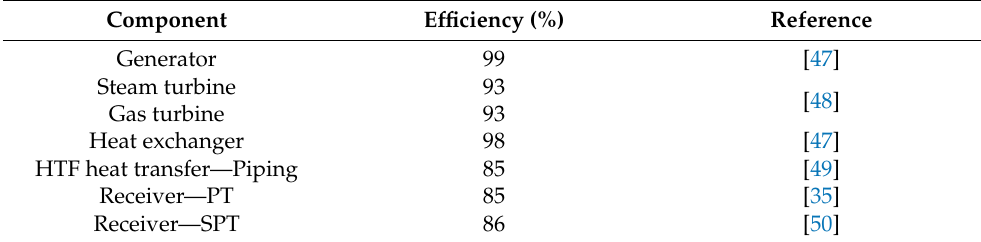
Figure 3. Technical components that affect the LCOE of CSP plants. Table 5. Efficiencies of common system components of both PT and SPT power plants.